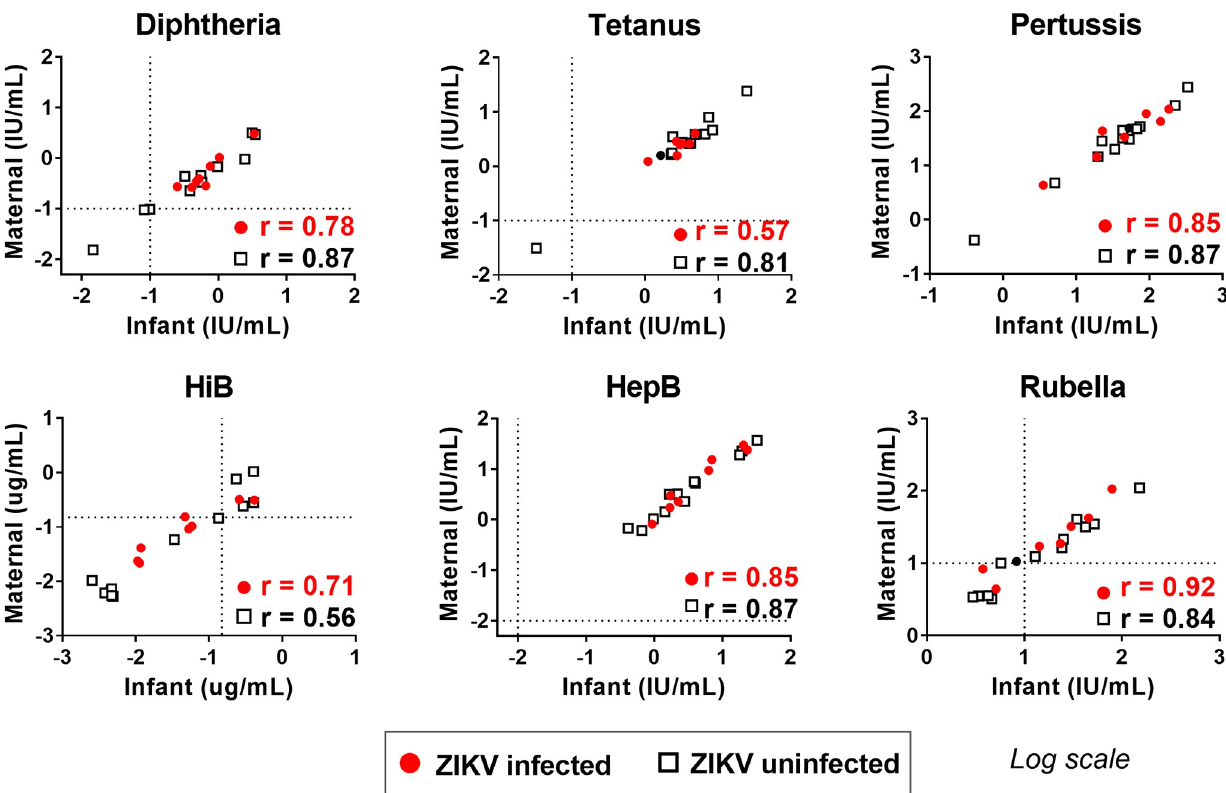
Fig 6. Strong correlation of maternal and infant vaccine-elicited IgG levels in ZIKV-infected mothers indicates efficient transplacental transfer during maternal ZIKV infection. IgG response to vaccine antigens in infant cord blood plasma and maternal plasma collected at delivery were measured by a binding antibody multiplex assay. Concentrations of vaccine-elicited IgG responses were calculated from reference sera standards as International Units (IU)/mL or μ g/mL. ZIKV-infected (n = 8) and uninfected (n = 12) subjects are indicated in red and black respectively, and dotted lines denote WHO established protective IgG levels. Kendall Tau correlations were performed for each ZIKV infection group, with p < 0.05 for